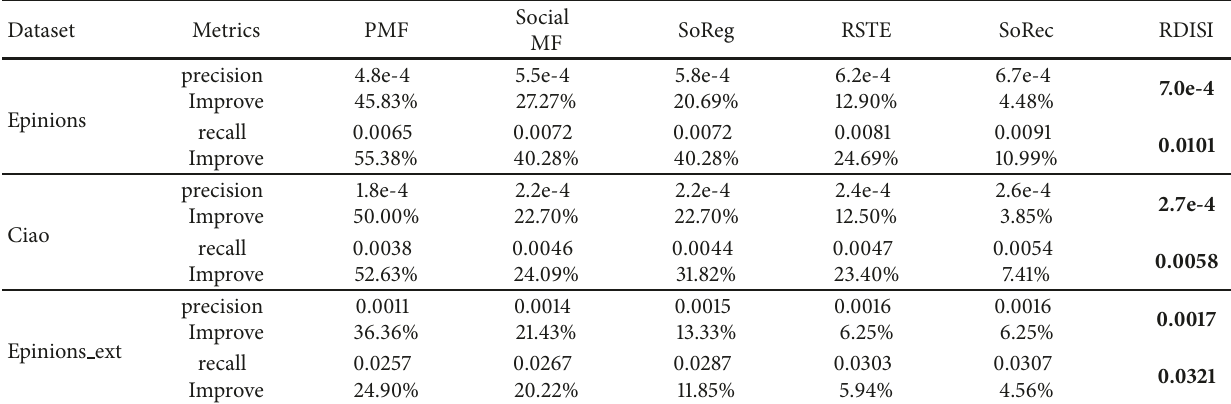
Table 7: Performance comparisons (precision and